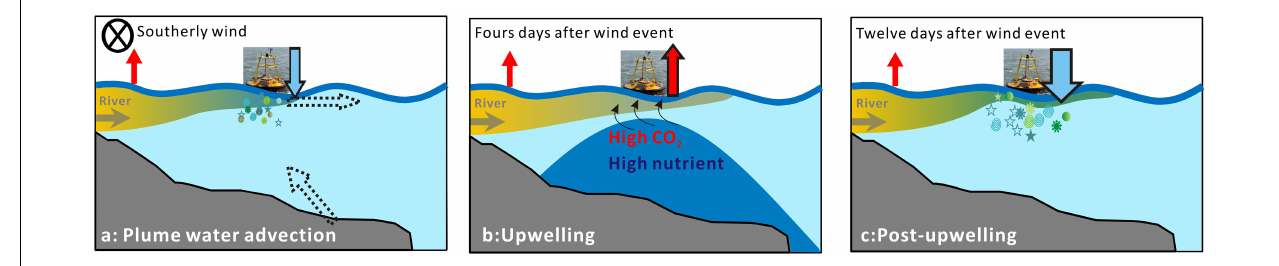
FIGURE 7 | Schematic of carbon flux variations in the Changjiang plume under south winds at plume water advection (a) , upwelling (b) , and post-upwelling (c) stages. The arrows on the right side of the buoy show the air-sea CO 2 fluxes in our results (blue arrow denotes carbon sink, while red arrow denotes carbon source). The horizontal and tilt dash arrows in panel (a) denote horizontal extension of plume waters and upwelling after the wind event, respectively. Upwelling of subsurface waters in panel (b) is marked by dark